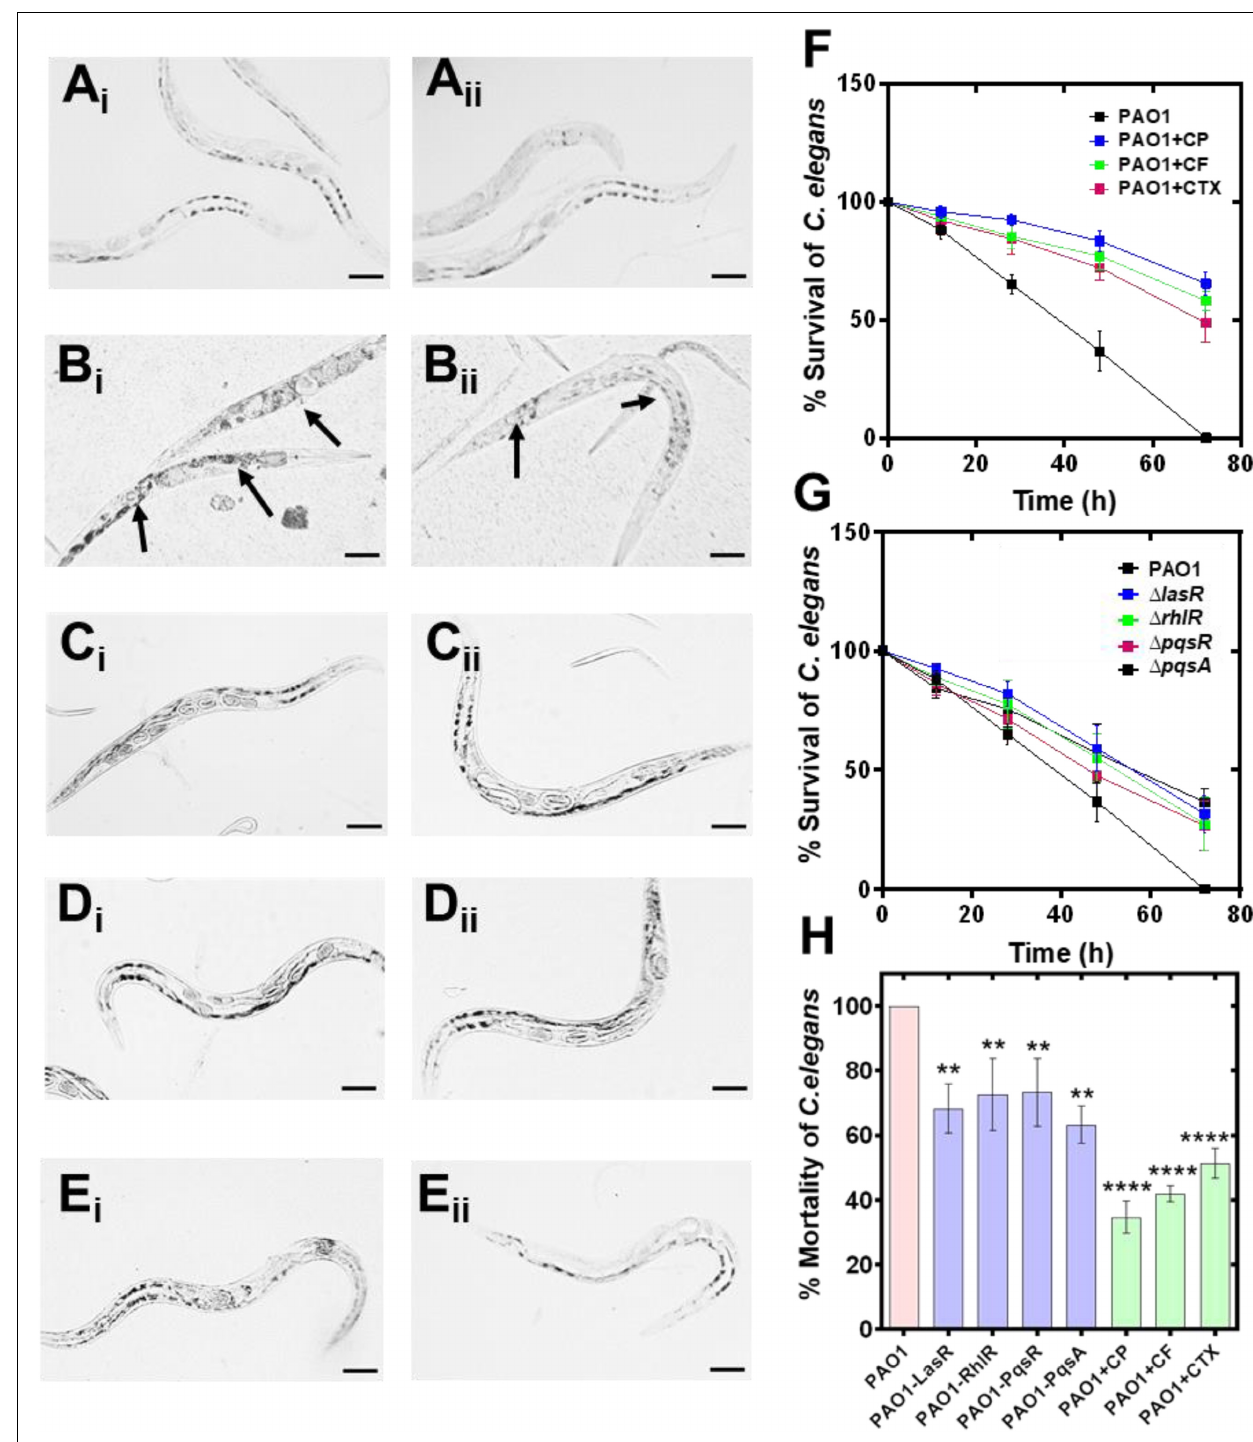
FIGURE 8 | Anti-virulence effect of cephalosporins against Pseudomonas aeruginosa PAO1 induced tissue damage in Caenorhabditis elegans . Light microscopic images of C. elegans showing the protective effect of cephalosporin in P. aeruginosa mediated tissue damage; control C. elegans (healthy) (A i ,A ii ) ; C. elegans exposed to PAO1 (B i ,B ii ) ; PAO1 + CP (C i ,C ii ) ; PAO1 + CF (D i ,D ii ) , and PAO1 + CT (E i ,E ii ) . Percentage survival of PAO1 infected C. elegans in the presence of CP, CF, and CT (F) . Percentage survival of C. elegans by the QS mutant strains ( (cid:49) lasR, (cid:49) rhlR, (cid:49) pqsR, and (cid:49) pqsA ) and control PAO1 strain (G) . Comparative analysis of the % mortality of C. elegans after 72 h by control PAO1 strain, isogenic QS mutant strains ( (cid:49) lasR, (cid:49) rhlR, (cid:49) pqsR, and (cid:49) pqsA ), and after treatment with CP, CF, and CT (H) . ** p ≤ 0.01, **** p ≤ 0.0001.